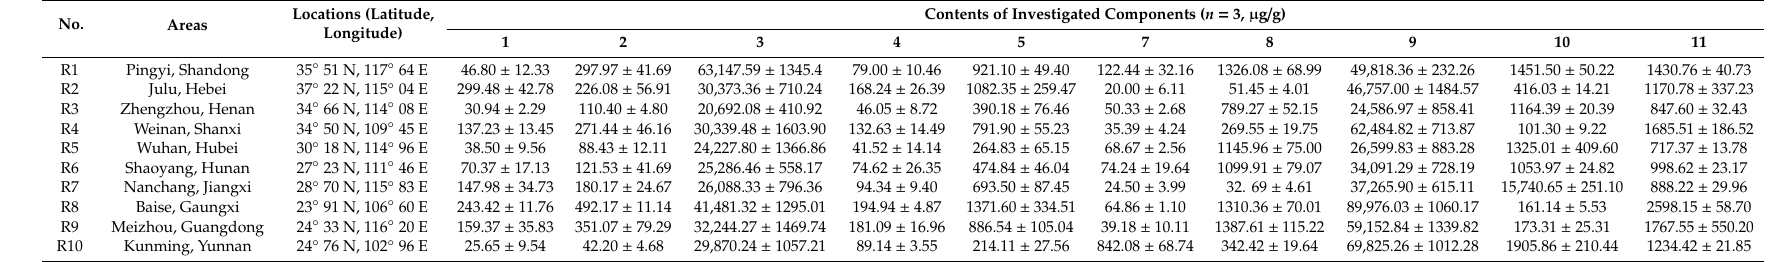
Table 4. Contents of investigated components in Lonicera japonica